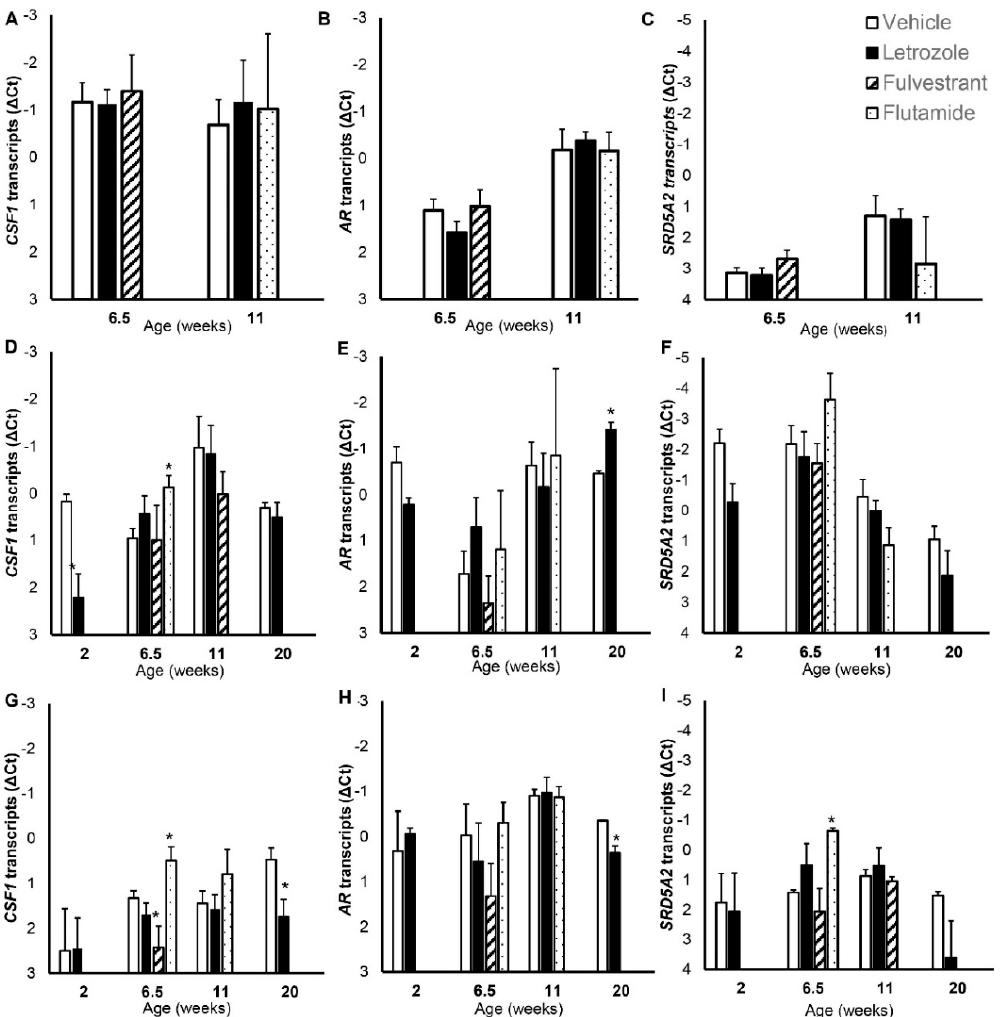
Figure 7. Effects of estrogen and androgen signaling on CSF1 , AR , and SRD5A2 gene expression in testes ( A – C ), prostate ( D – F ) and seminal vesicles ( G – I ). Values represent means and SEM. Estrogen signaling was reduced in littermates by inhibiting estradiol synthesis with letrozole or by blocking signaling via nuclear estrogen receptors with fulvestrant. Androgen signaling was blocked with flutamide. * indicates mean differs from vehicle-treated littermates, p < 0.05.